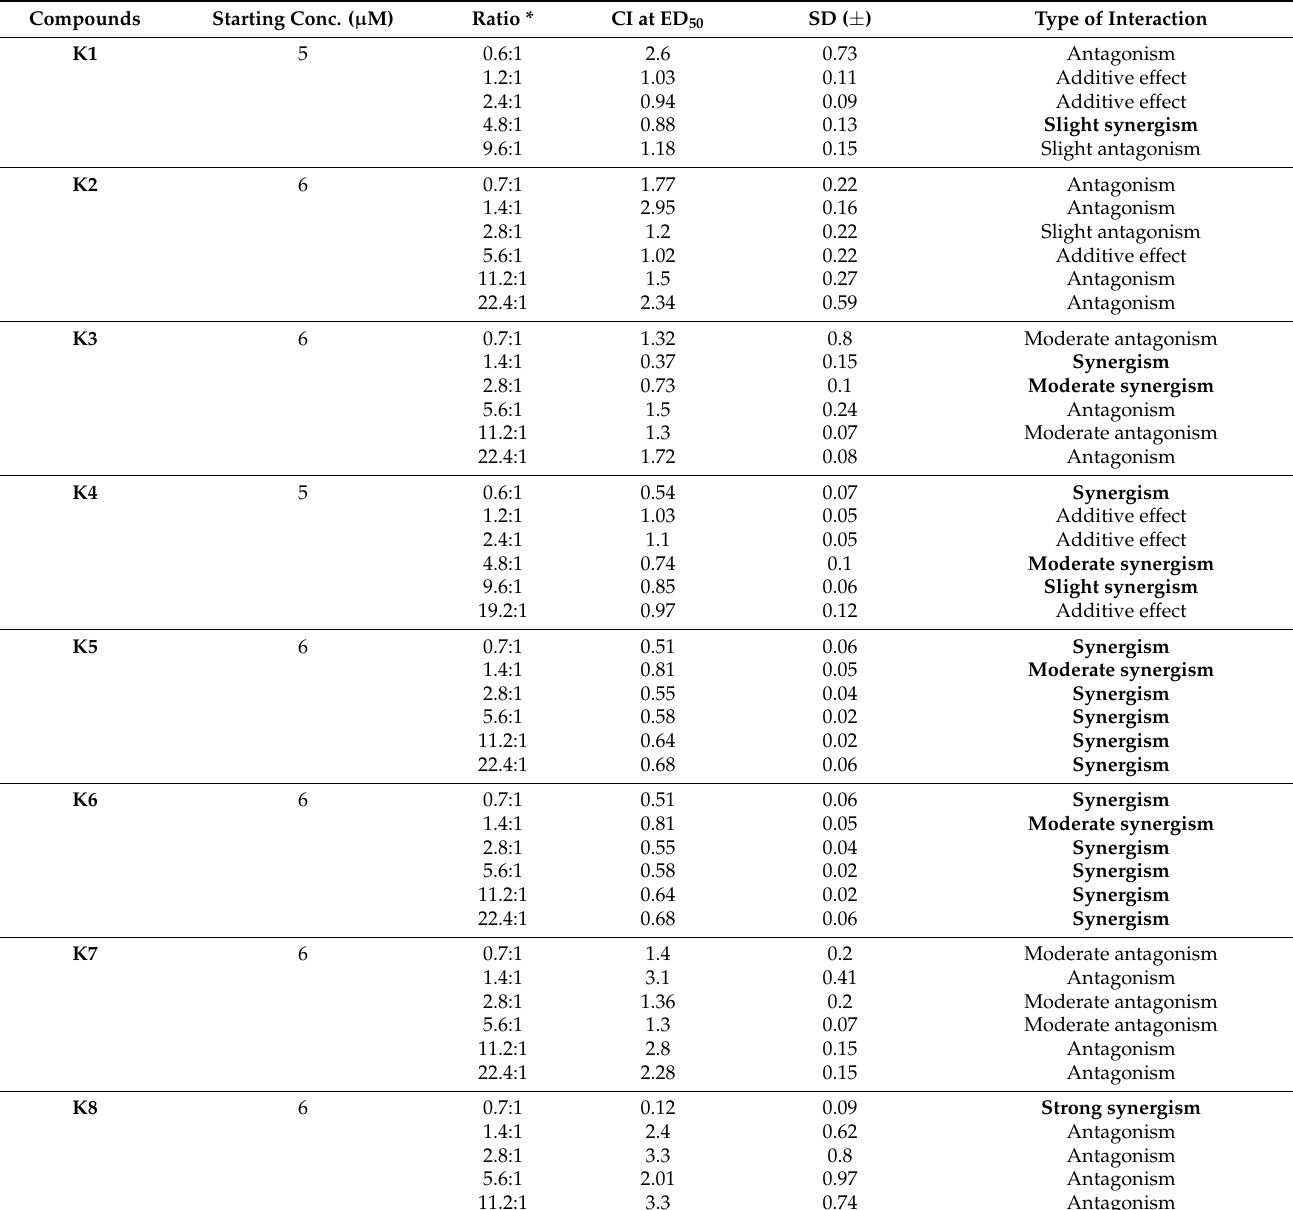
Table 5. Interaction of ketone-selenoesters with doxorubicin on MDR Colo 320 cells. Compounds Starting Conc. ( µ